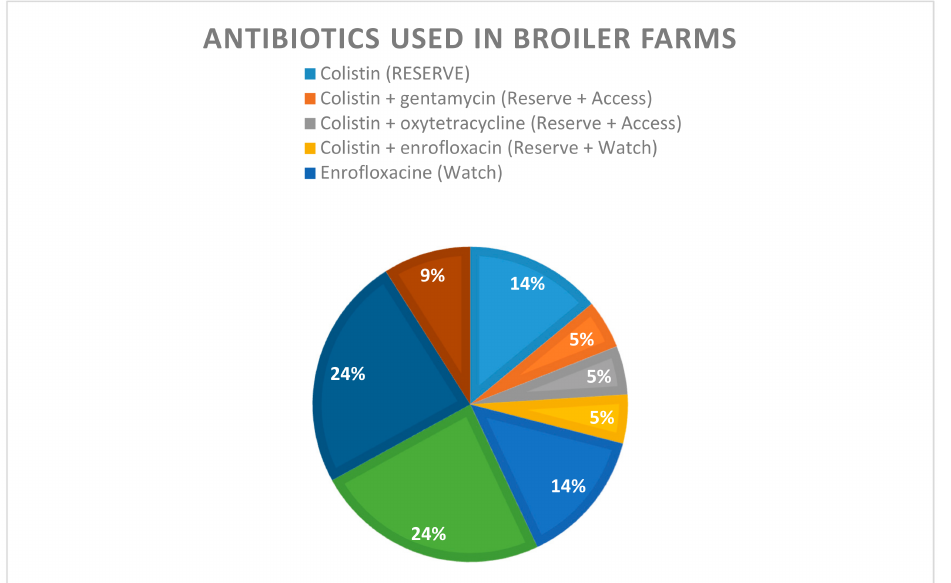
Figure 1. Antibiotics used in broiler chicken farms and their WHO AWaRe category.